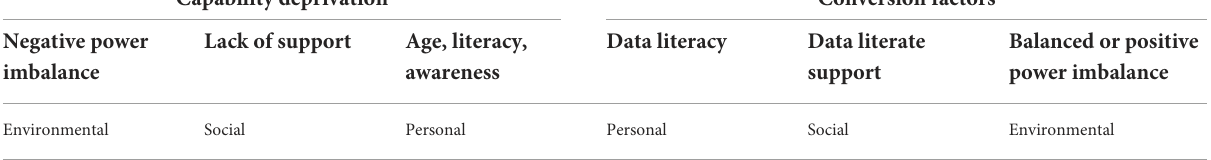
TABLE 2 Capability approach as a framework to for vulnerability and data